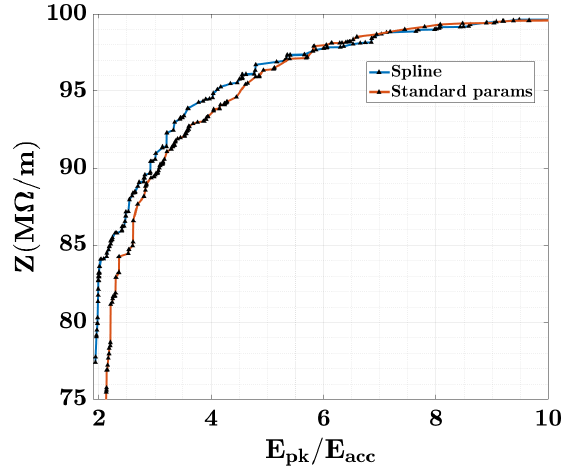
=E Pareto FIG. 8. Comparison of Z vs E pk acc model vs standard parameters for the C-band cavity, showing an improvement when splines are